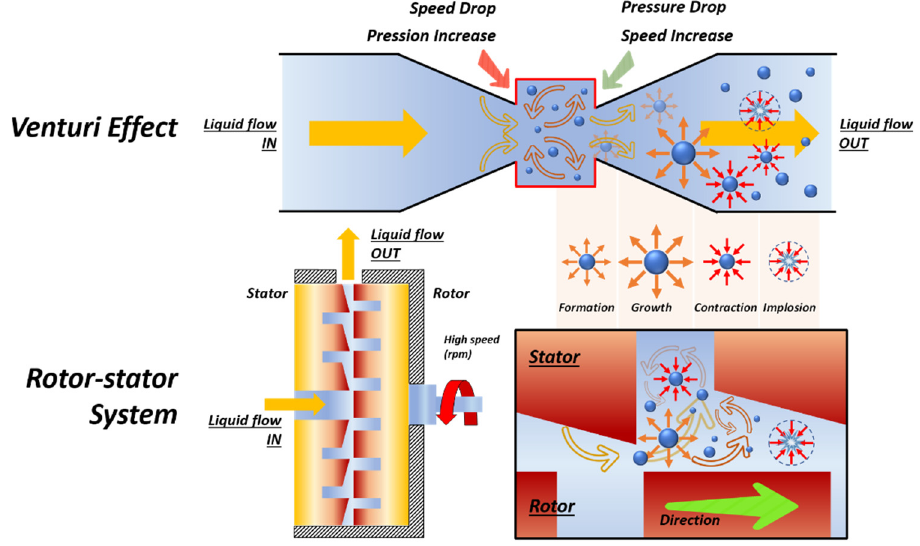
Figure 3. Hydrodynamic cavitation phenomenon in a fluid: Venturi effect and rotor-stator system. The HC can be generated by Venturi tubes, orifice plates, throttling valves or rotating